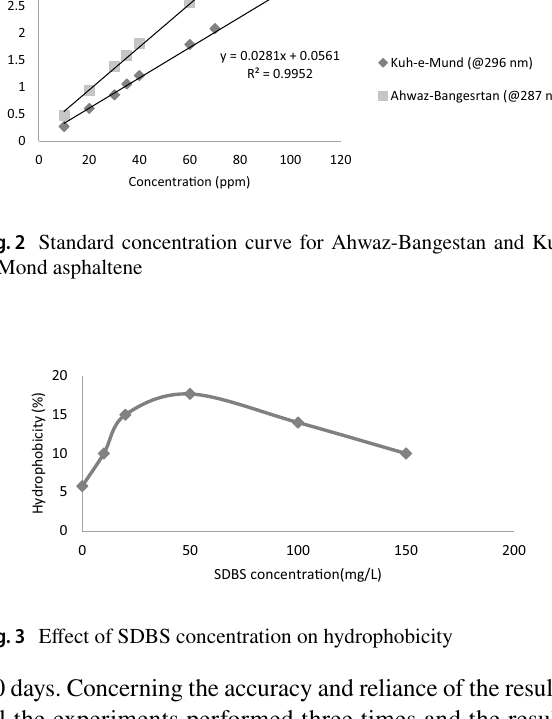
Fig. 1 Proposed molecular structure for asphaltene sample extracted from left: Bangestan oil and right: Kuh-e-Mond oil (Amin et al. 2011) Table 1 Utilized microorganisms for asphaltene biodegradation Bacteria genera